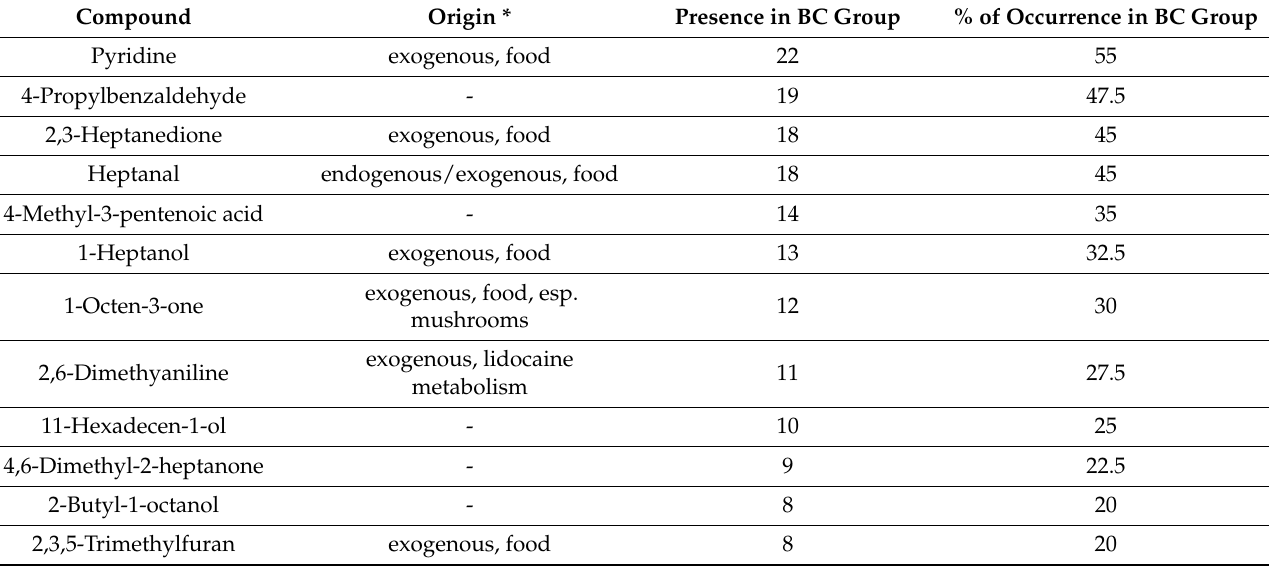
Table 1. Selection of compounds occurring only in the group of patients with bladder cancer.